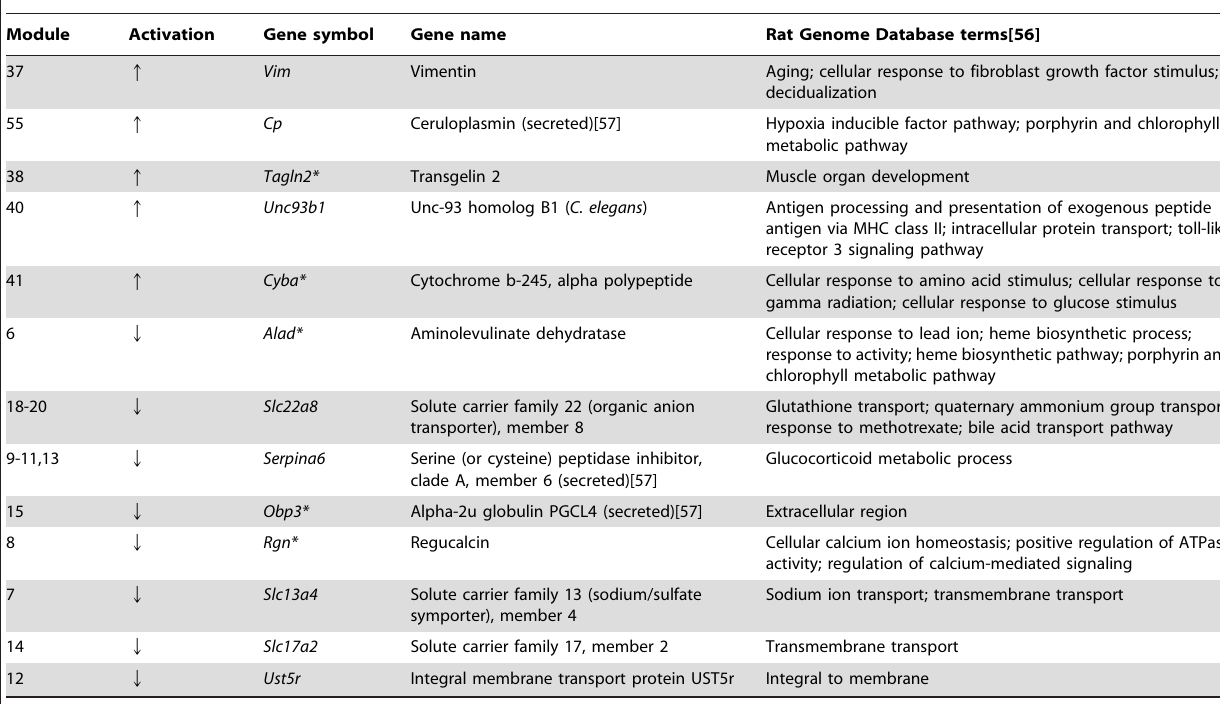
Table 5. Gene signatures for Periportal fibrosis .